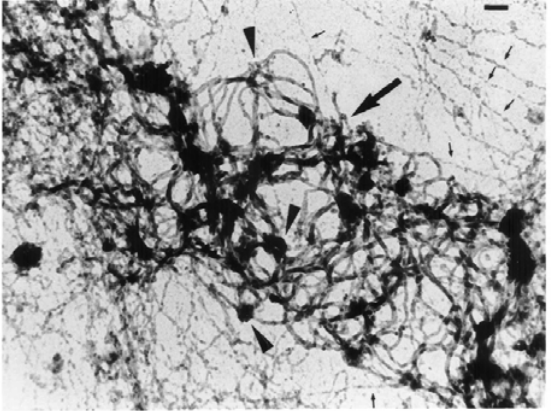
Fig. 4 – Afibrillar network (large arrow) is observed presenting curved filamentsattachedtoNPCs(arrowheads)andrelatedtochromatinfibers (small arrows). Several filaments converging to a same NPC are visu- alized in the upper side of the network (arrowhead). Spreads of whole